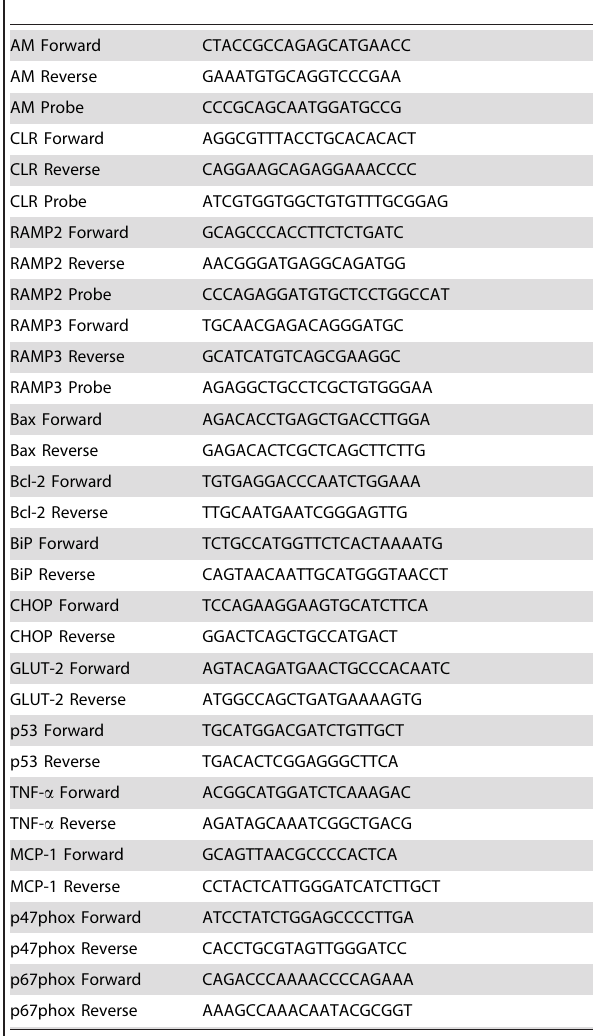
Table 1. Primers and probes used for quantitative real-time